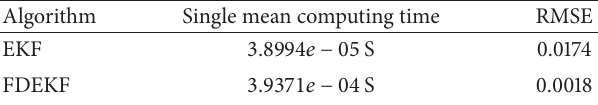
Table 2: Comparison of SOC